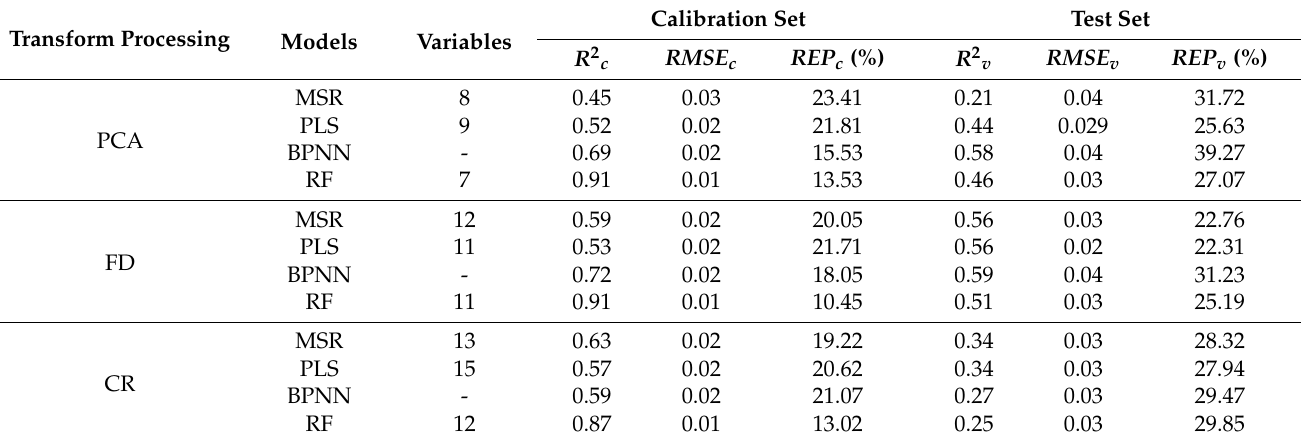
Table 7. Anth estimation models based on principal component analysis (PCA), first-order differential (FD), and continuum removal (CR)